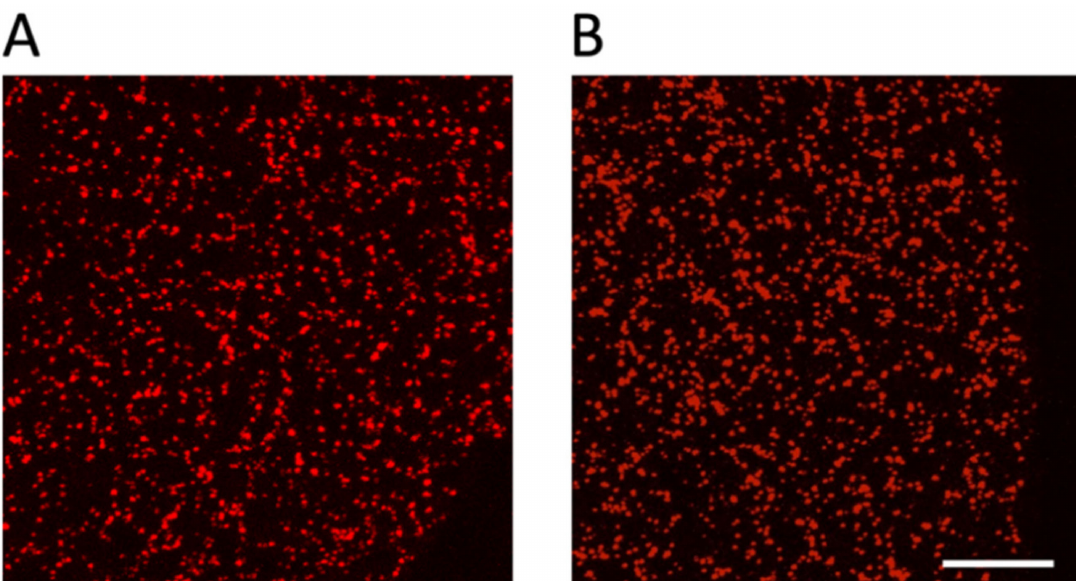
Figure 3. Platelets are homogenously distributed in an unconstrained retracting clot. Platelet-rich plasma (PRP) was either recalcified ( A ) or not ( B ) before induction of clot formation by the addition of thrombin (final concentration of 2.5 U/mL). Clots were fixed after 60 min of retraction at RT, and 14 µ m sections were stained to detect the position of platelets using an antibody against α IIb integrins present on the platelet surface; scale bar, 100 µ